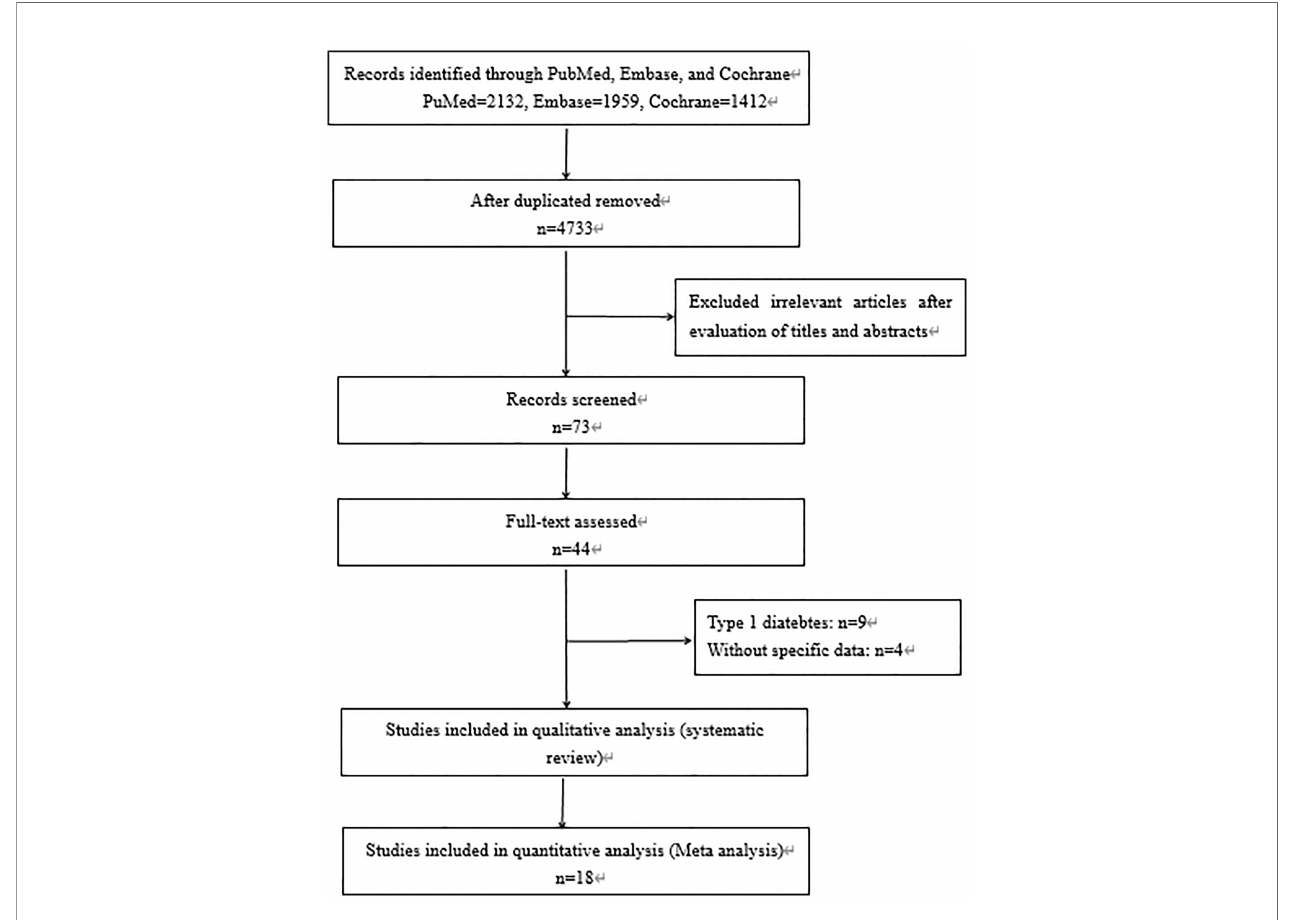
FIGURE 1 | Flow diagram of study